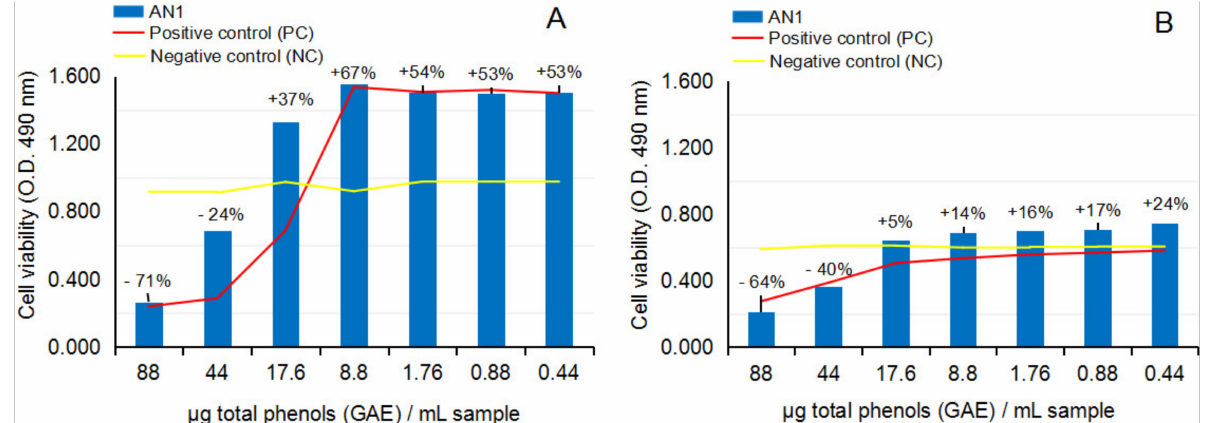
Figure 6. Effect of crude ethanolic extract from fresh Anemone nemorosa L. plant material (AN1) on human normal brain cell line NHA and human tumor brain cell line U87, in cytotoxicity MTS assay. ( A ) NHA cell line viability after 24 h of exposure to test vegetal extract AN1. ( B ) U87 cell line viability after 24 h of exposure to test vegetal extract AN1. All determinations were made in triplicate series, and the results are calculated as an average. Graphs A and B also present the percentage of cell viability by comparison to negative control series (CN). According to the statistical calculation, the results of the NHA and U87 cell lines in the cytotoxicity experiment were not statistically significant ( p > 0.05, n = 3).